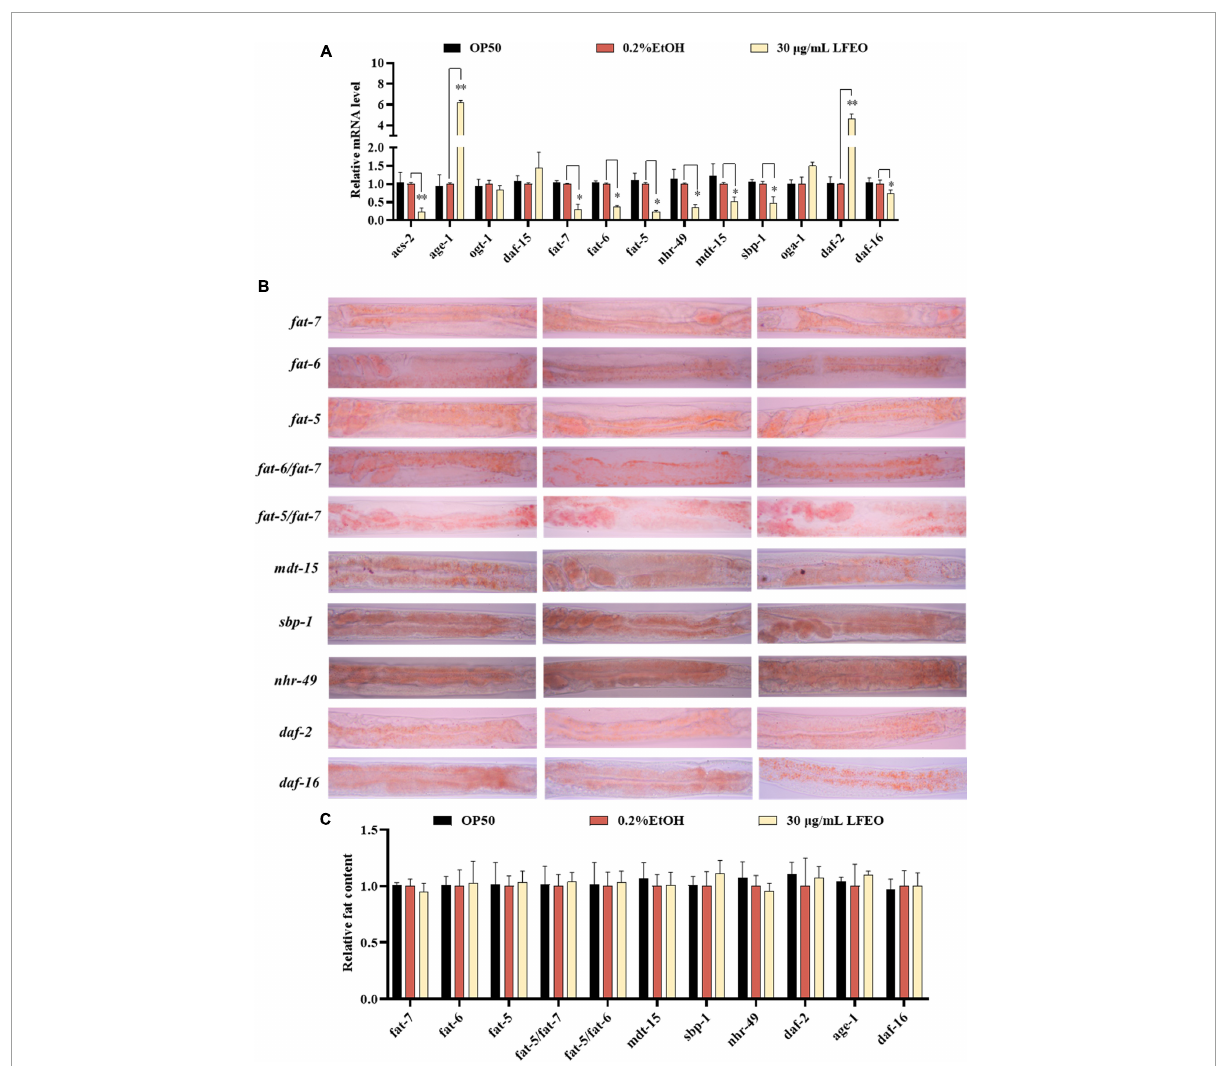
FIGURE7 The molecular mechanisms of litchi flower essential oil (LFEO) on fat accumulation and reduction. (A) The mRNA level was determined by qRT-PCR and normalized to the expression of act-1. (B) The representative oil red O (ORO) staining images of the fat content in age-1 , daf-2 , daf-16 , sbp-1 , mdt-15, nhr-49 , fat-5 , fat-6 , fat-7 , fat-5 / fat-6 double, and fat-5 / fat-7 double mutant worms. (C) Quantitative analysis of ORO staining intensity using ImageJ software. Statistical analysis of the results was done using a one-way ANOVA with Bonferroni tests as post hoc comparison; different letters indicate a significant difference, p < 0.05; with three biologically independent samples in panel (A) and at least 15 worms per group in panel (C)